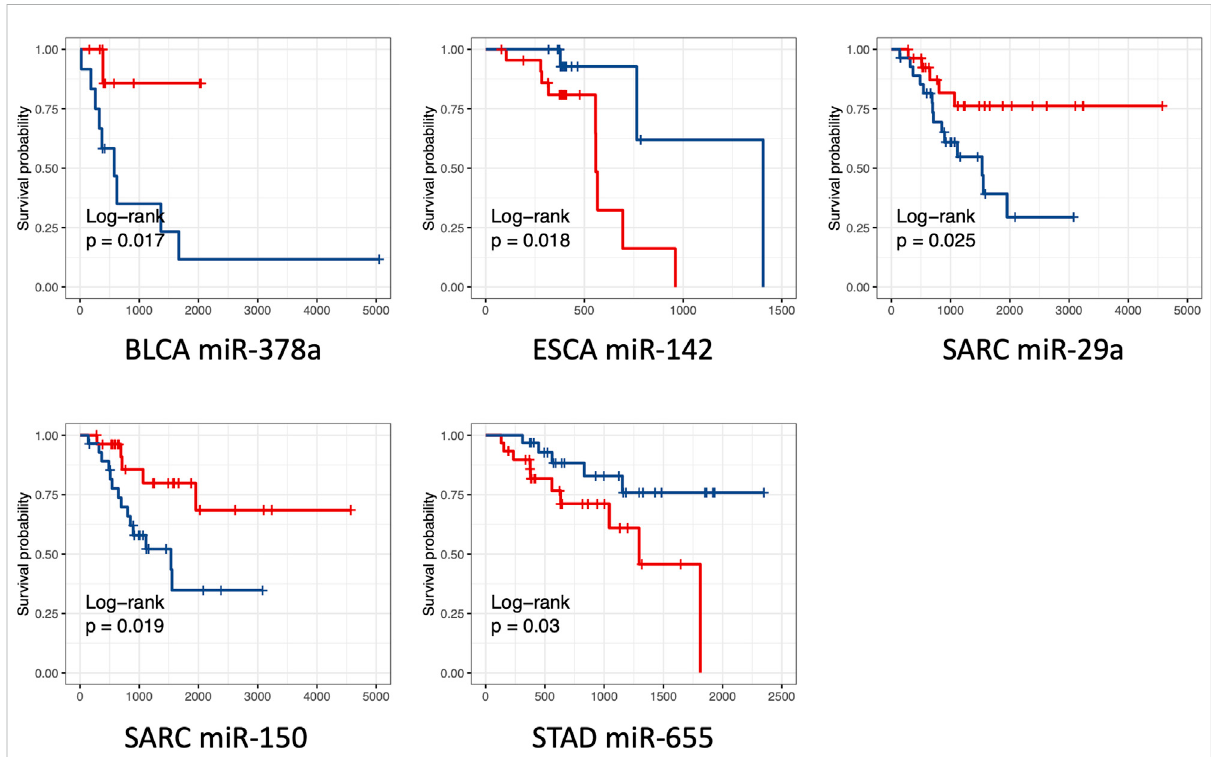
FIGURE 6 KaplanMeieroverallsurvivalcurvesforpatientswithonesinglemiRNAstrati fi edbyhigh versus lowmiRNAexpression.Resultsfrom fi vemiRNAs withlow p values( p values < 0.05)wereshown.Thehighandlowexpressionwasindicatedwithredandbluecolor,respectively. p valueswerederived from log-rank